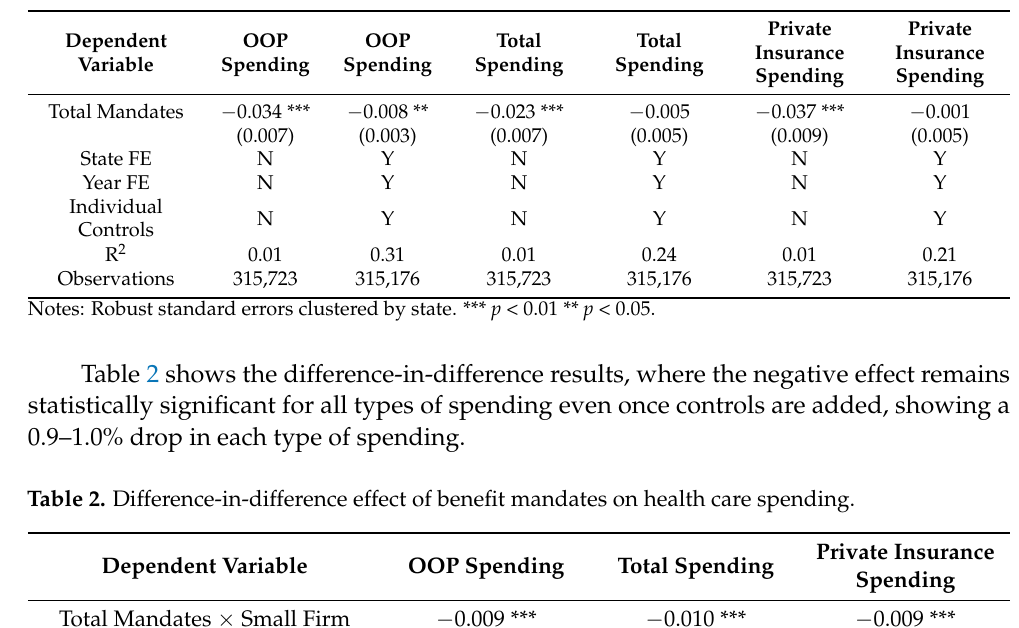
Table 1. Effect of benefit mandates on health care spending.